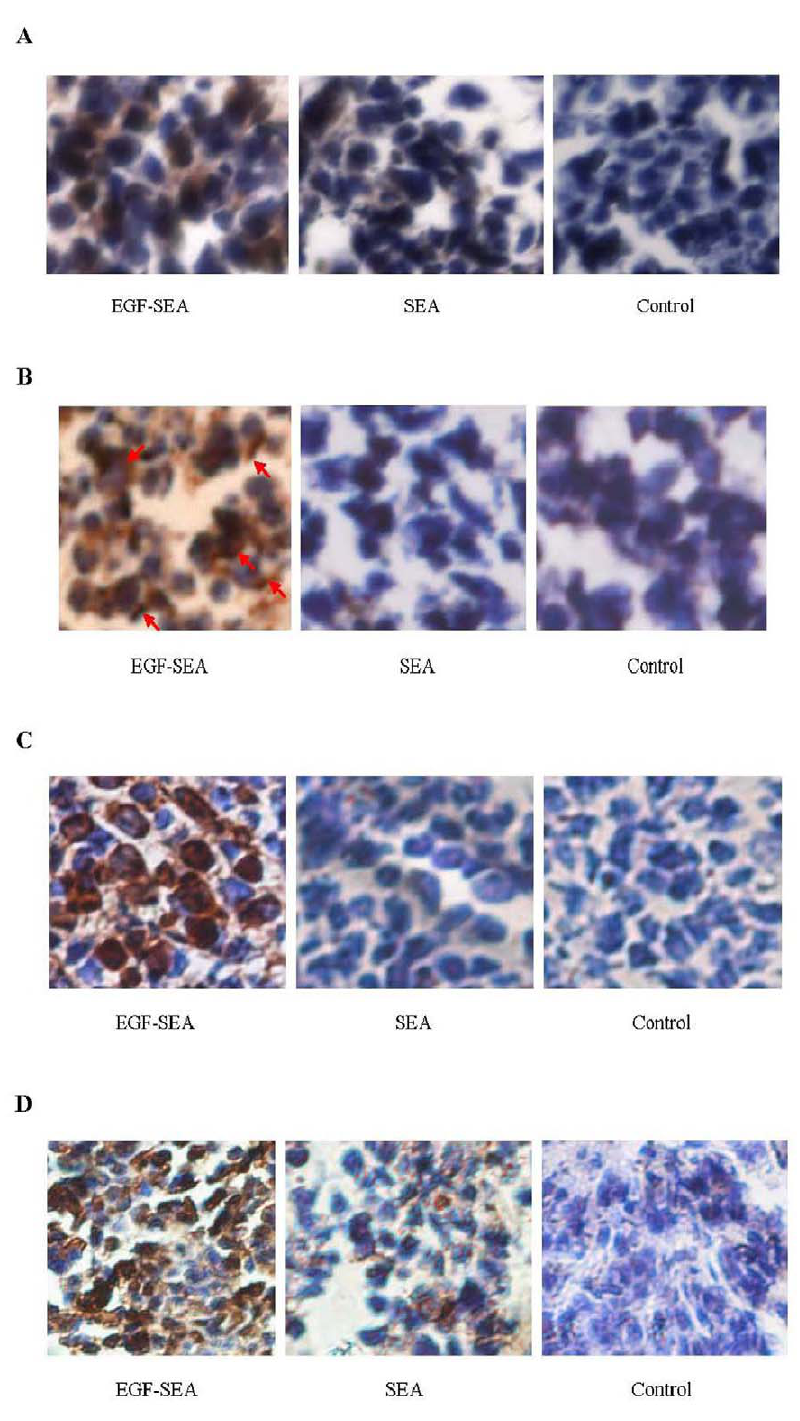
Figure 5. Apoptosis of S180 carcinomas. (A) Detection of Fas expression in S180 tumor cells using rabbit Fas-specific polyclonal antibody. Fas molecules were detected on the surface of S180 cells (brown staining). (B) Perforin secretion by T cells in S180 tumors. Perforins were detected by rabbit perforin-specific polyclonal antibody, and found to be pore-forming (red arrows). (C) Secretion of granzyme B by T cells in S180 tumors. Granzyme B proteins were detected by rabbit granzyme B-specific polyclonal antibody. (D) Cell death in S180 carcinomas. Apoptotic tumor cells were detected by TUNEL staining. Microscope magnification: 6 400 in A to D. doi:10.1371/journal.pone.0016642.g005 rely upon the location where superantigen-activated T lymphocytes adhered and proliferated, demonstrating that the targeting of tumor-infiltrating CTLs by EGF-SEA was required for the restriction of cytokine cytotoxicity to the tumor site.